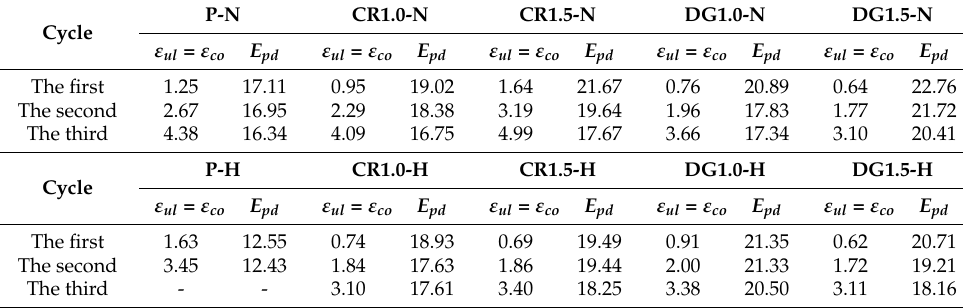
Table 6. Average modulus after each cycle of specimen.